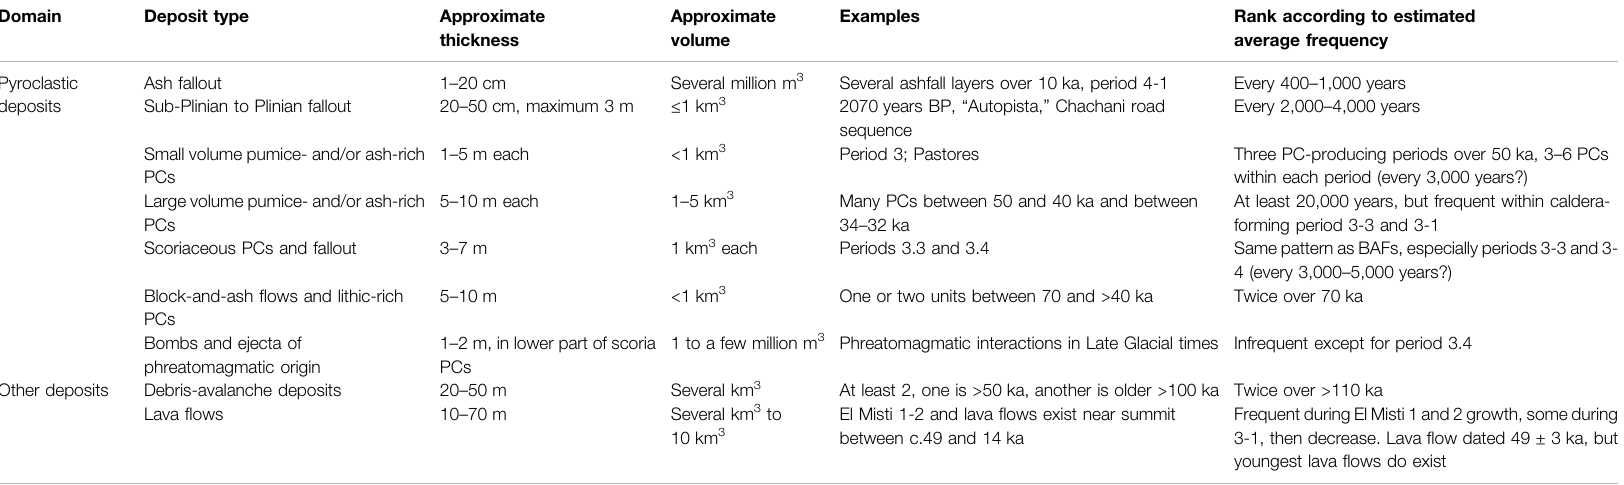
TABLE 1 | Summary of magnitude and frequency data for each eruptive and non-eruptive phenomenon at El Misti volcano collected from eruptive records over the last 50 kyr of activity. Modi fi ed from Sandri et al. (2014).